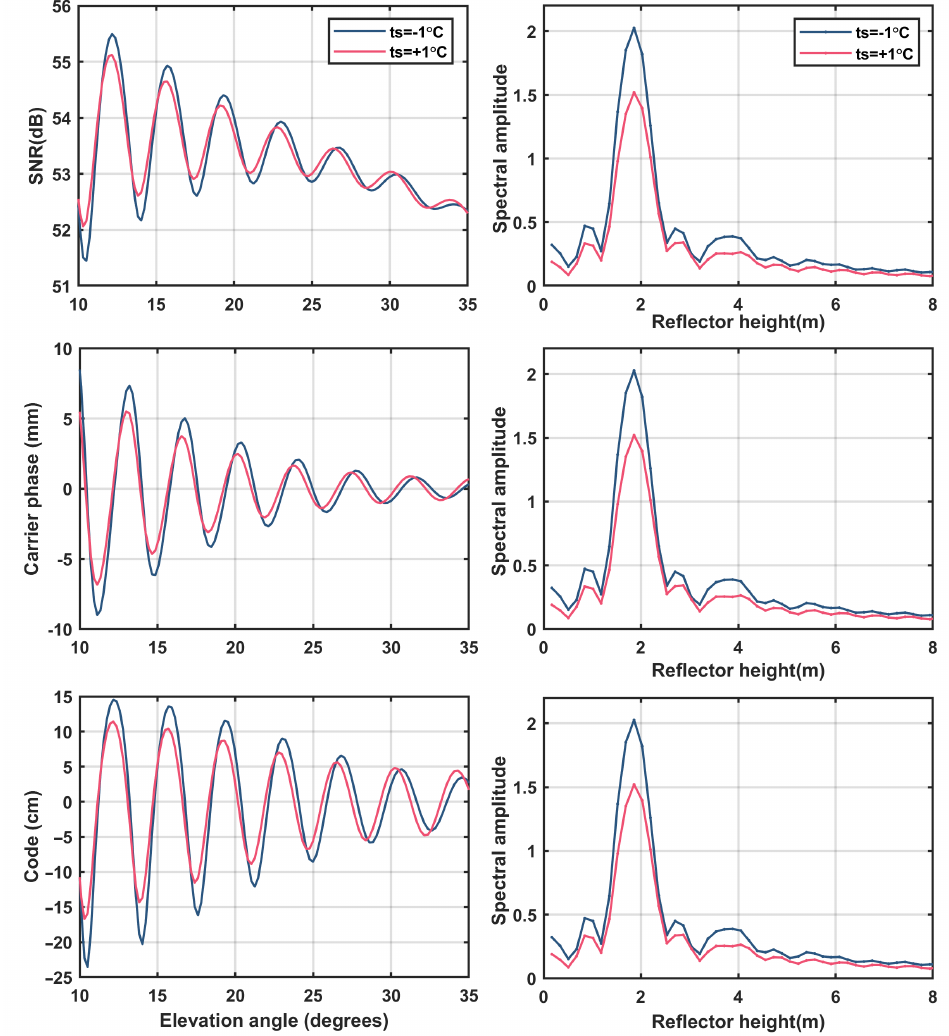
Figure 5. The corresponding multipath observations (SNR, carrier phase and code pseudorange) and effective reflectometer height changes during freeze–thaw